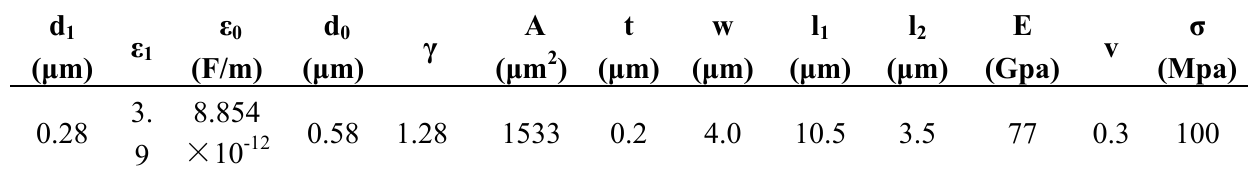
Table1. The correlative parameters of the designed GLM [8].